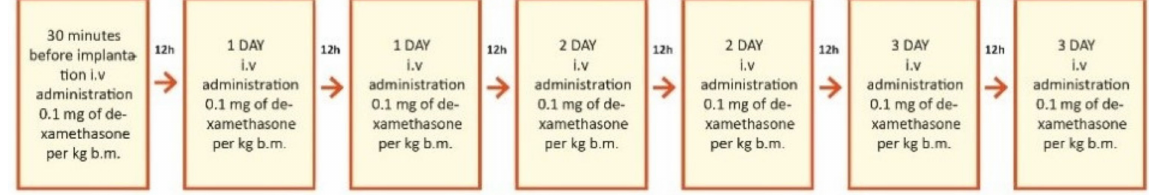
Figure 2. Study design for the first group, treated with intravenous steroid only. i.v.—intravenous; b.m.—body mass = body weight.